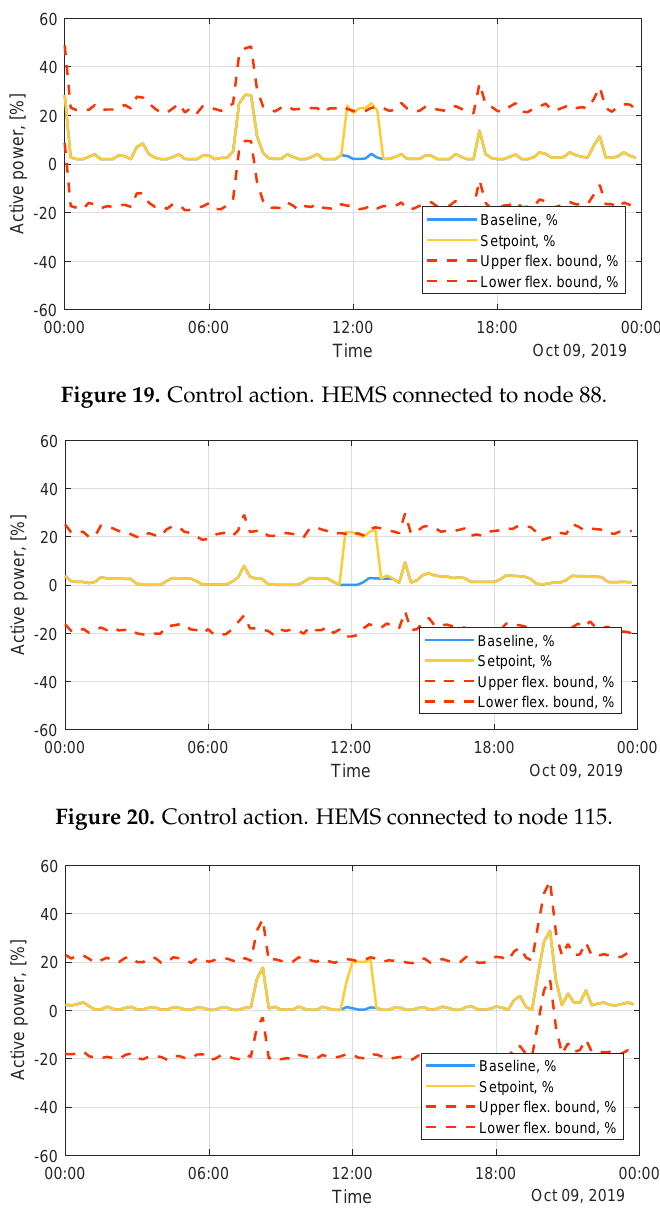
Figure 21. Control action. HEMS connected to node 132. Table 5. Control action. Flexibility requested to consumers with